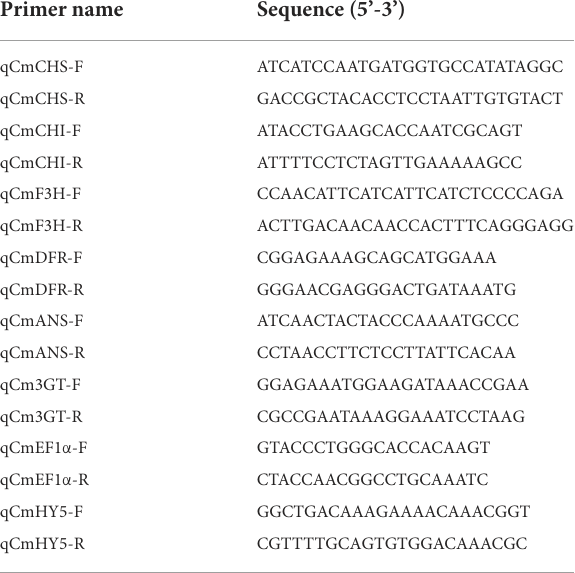
TABLE 1 Primers used in the